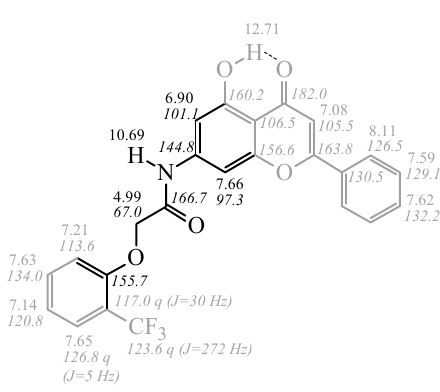
Figure 2. 1 H and 13 C NMR chemical shift (given in ppm) assignments for compound 20 .